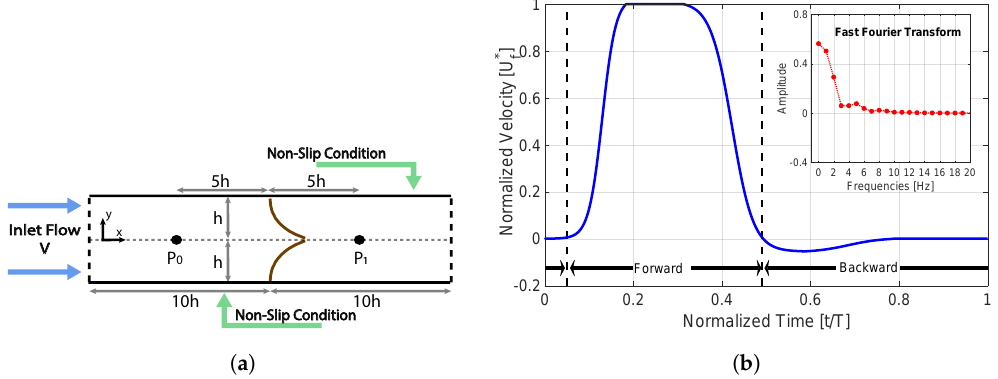
Figure 1. ( a ) Layout of the system: h represents the semi-height of the channel. P 0 and P 1 are the points used to measure pressure. The original setup can be found in [42]. ( b ) The normalized velocity ( t ∗ ) used for the Fluid-Structure Interaction (FSI) simulations. ( b ) represents the fast Fourier curve U ∗ f transform of the signal with its representative working